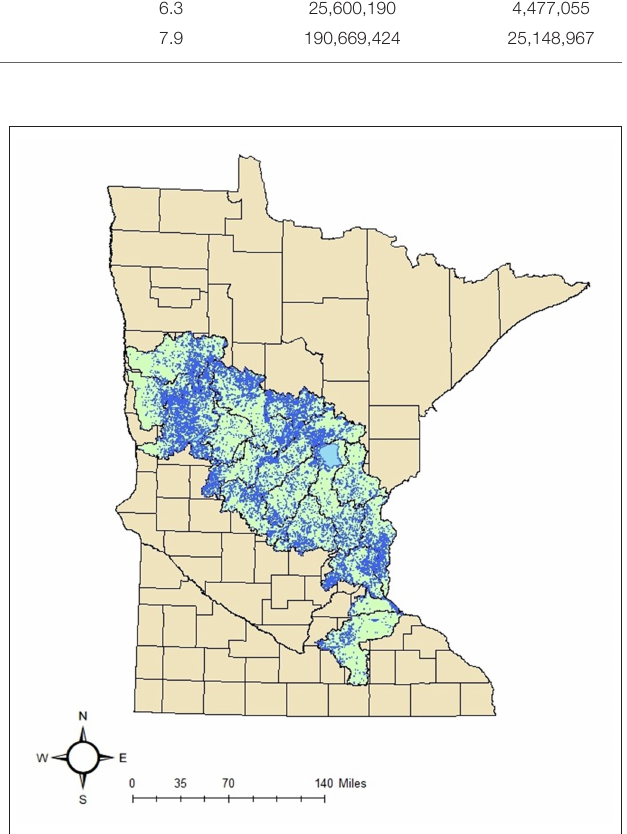
FIGURE 1 | Map of 40,054 lakes contained within 17 HUC-8 watersheds of central Minnesota used in lake volume